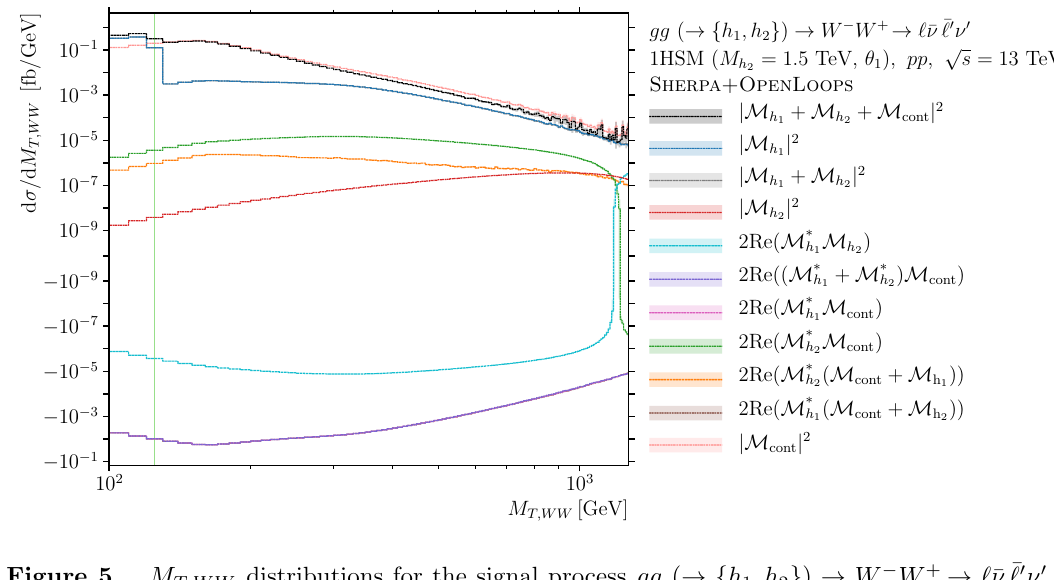
Figure 5 . M T,WW distributions for the signal process gg ( → { h 1 , h 2 } ) → W − W = 1500 GeV, θ 1 ) including its interference with the background in pp collisions at the 1HSM ( M h 2 √ s = 13 TeV. Other details as in figure